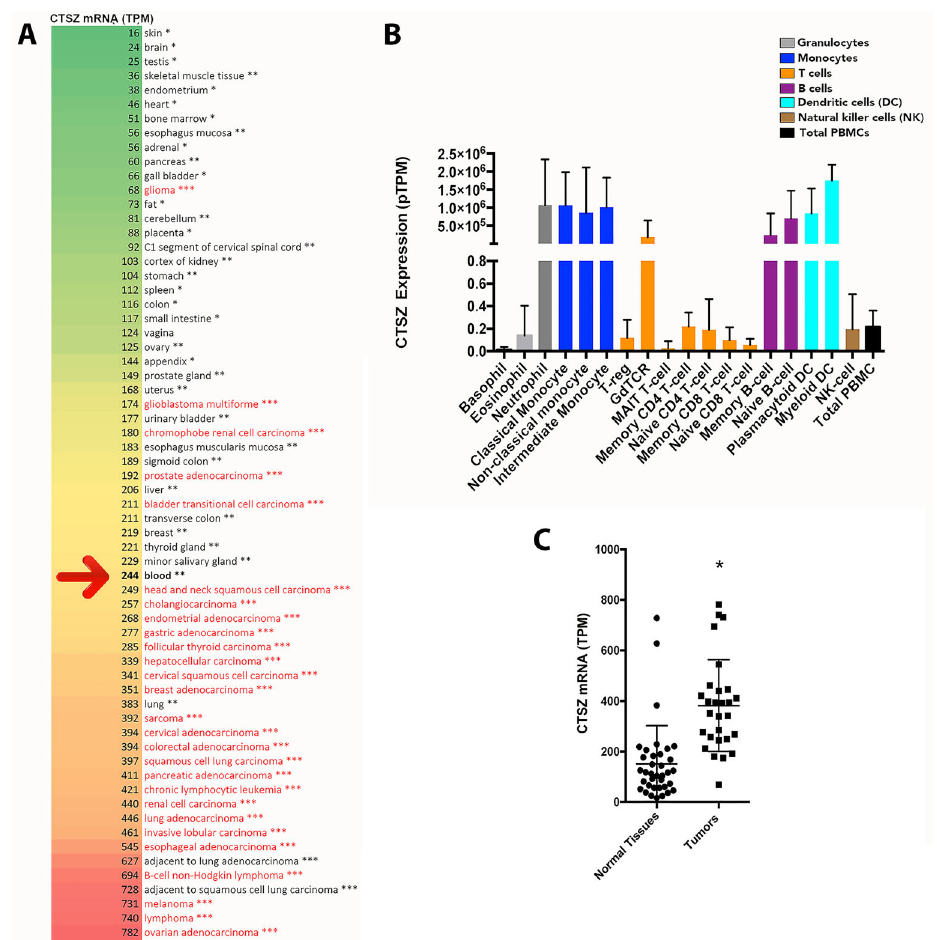
Figure 1. Bioinformatics data of cathepsin Z (CTSZ) expression. A , Heat map of CTSZ mRNA expression from several normal and cancer tissues. The red arrow indicates the expression of CTSZ mRNA in the blood of healthy subjects. Black font: healthy tissues; Red font: tumors. *RNA-seq mRNA expression from the HPA RNA-seq normal tissues project (https://www.proteinatlas.org), **RNA-seq data from the Genotype-Tissue Expression (GTEx) Project, and ***RNA-seq m from the Pan-Cancer Analysis of Whole Genomes (https://dcc.icgc.org/pcawg, data available in the Expression Atlas website). TPM: transcripts per kilobase million. B , CTSZ mRNA expression in different human immune cells from healthy subjects ’ blood. C , CTSZ mRNA expression in normal tissues versus tumors. *P o 0.05 ( t -test). We adapted the data presented in panel B from the Human Protein Atlas website